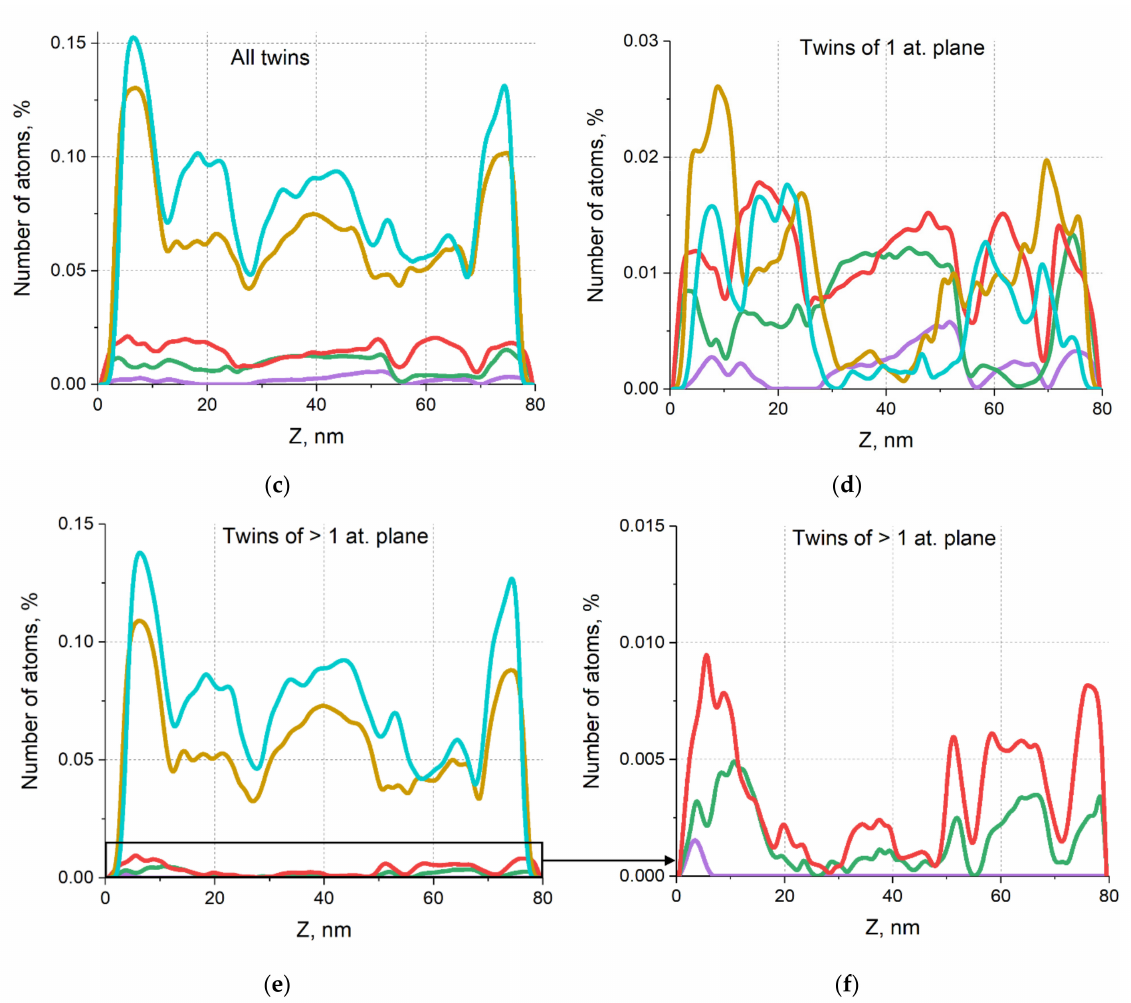
Figure 3. Z-axial distribution of the fraction of atoms constituting: ( a ) all defects, ( b ) ISFs, ( c ) twins, ( d ) twins with a thickness of 1 atomic plane, ( e , f ) twins with a thickness of more than 1 atomic plane for different strains.